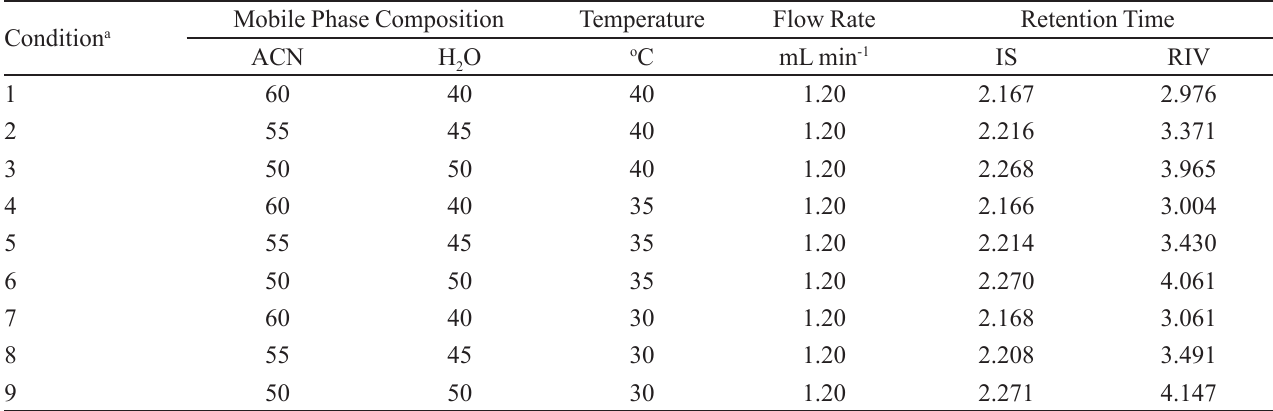
TABLE I - Retention time of IS and RIV on various conditions of mobile phase composition and chromatographic column temperature Mobile Phase Composition Condition a